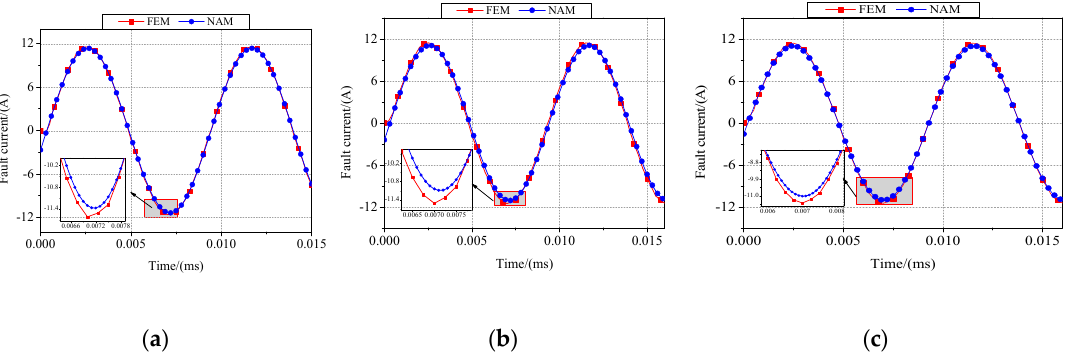
Figure 17. The waveforms of the fault current i f when there are six turns shorted in layer 2 of the faulty coil: ( a ) the shorted turns are the turns from no. 13 to no. 18; ( b ) the shorted turns are the turns from